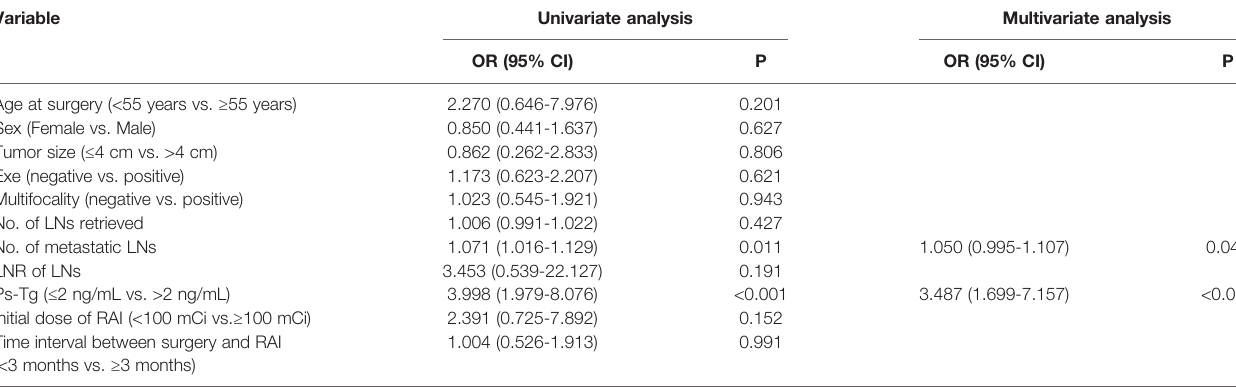
TABLE 4 | Univariate and multivariable analyses of prognostic factors for excellent response for pN1b PTC patients.